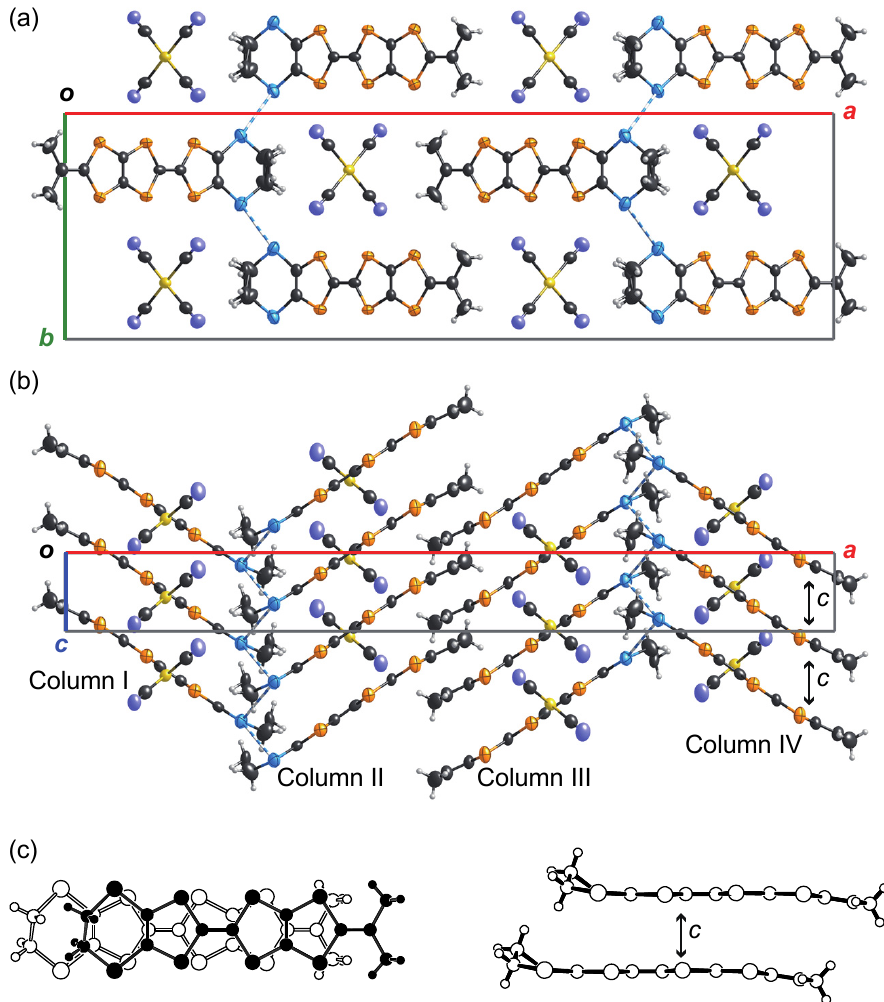
Intermolecular overlap integrals are calculated by the extended Hückel method [23] and are listed in Figure 6. Intrastack overlap integral c ( − 26.80  10 − 3 ) is much larger than integrals b1 , b2 , and p . The calculated band dispersion and the Fermi surfaces for 4 based on the tight-binding approximation